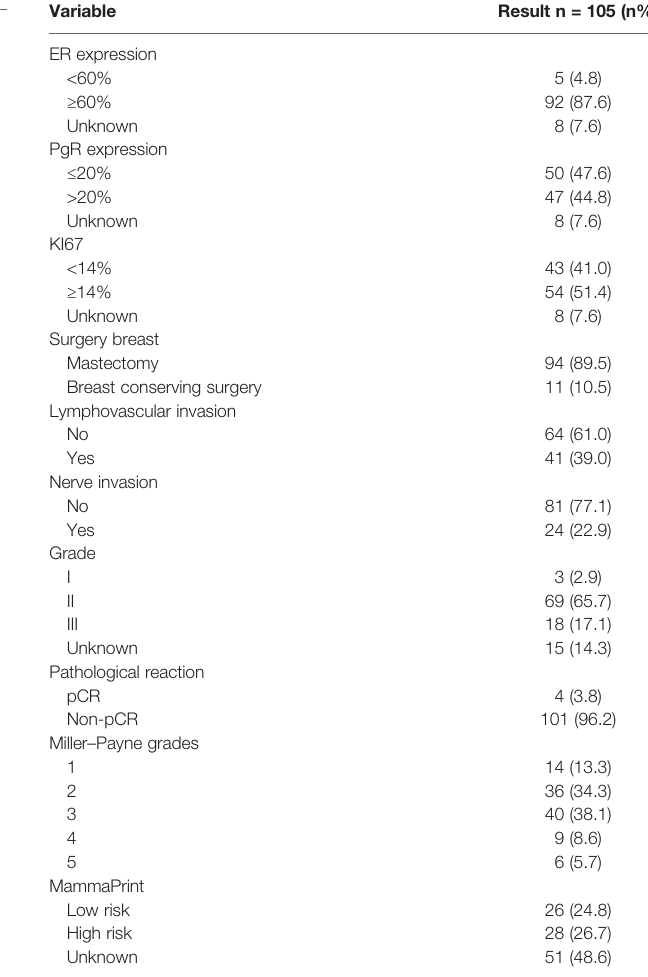
TABLE 2 | The postoperative clinicopathological characteristics of